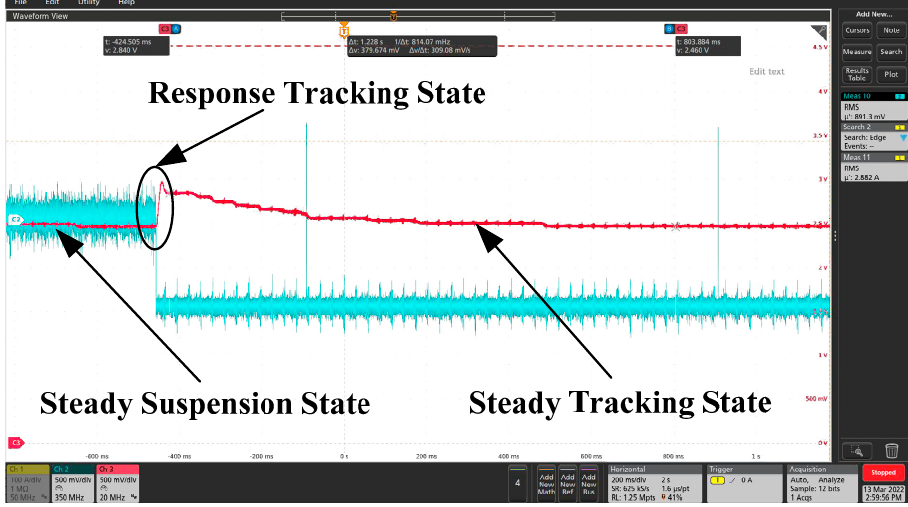
Figure 12. Displacement–time response curve under pulse excitation signal (pulse width: 100 μ s).